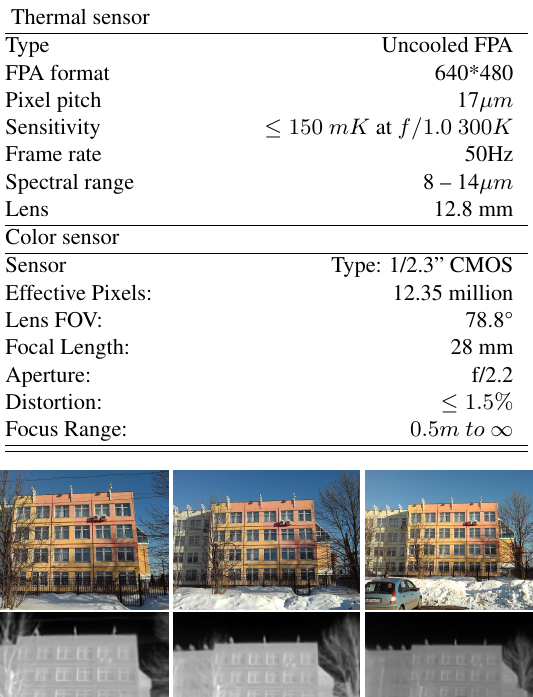
Table 3. DJI Mavic Pro cameras specification